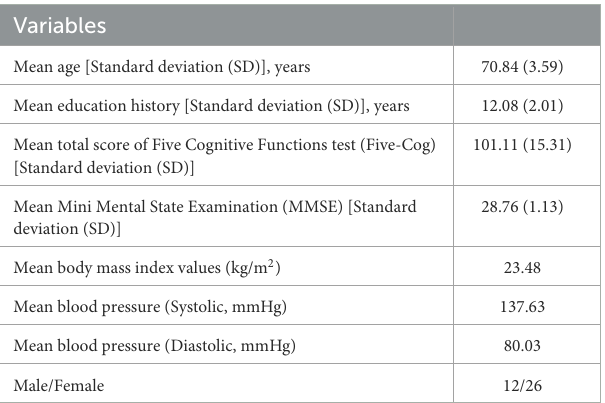
TABLE 1 Descriptive statistics and demographic information of the total